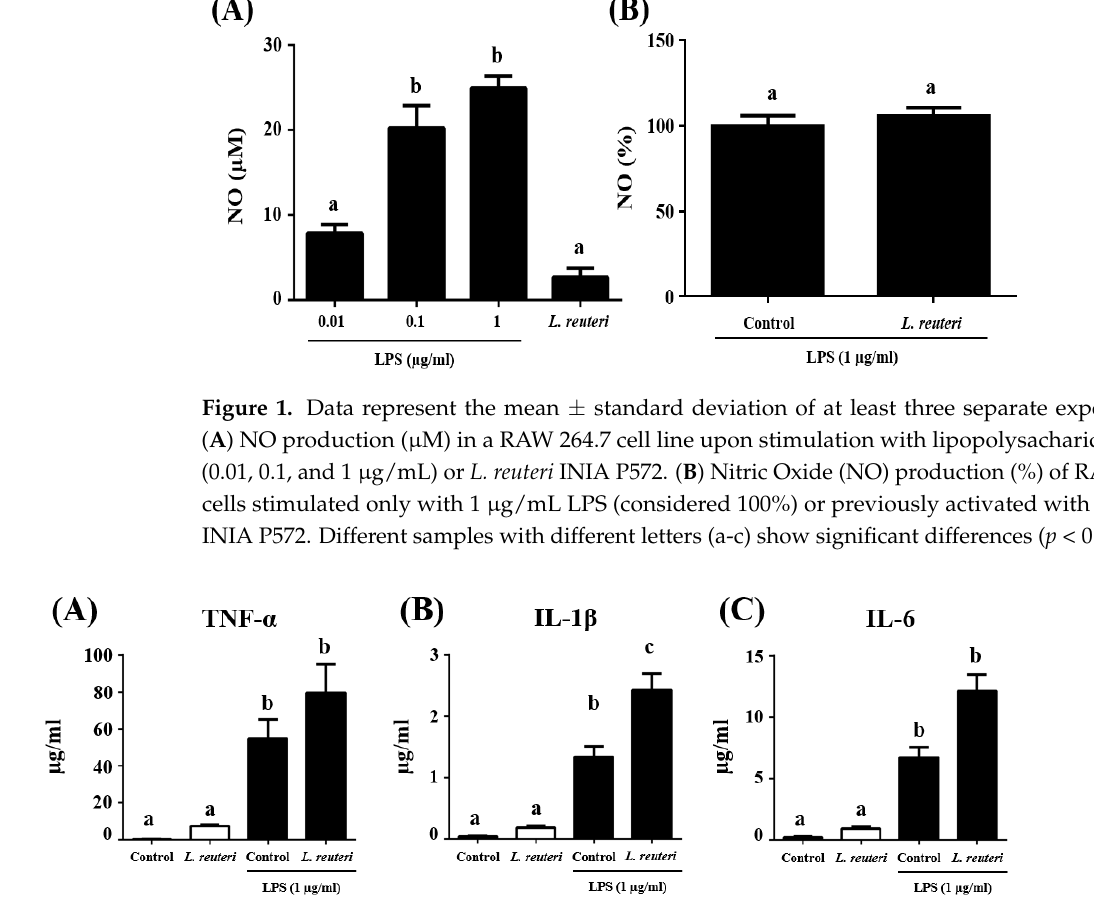
Figure 2. Tumor necrosis factor- α (TNF - α) ( A ), interleukin- 1β (IL - 1β) ( B ), and interleukin-6 (IL-6 ) ( C ) levels (µg/mL) in RAW 264.7 cells, untreated (white) or treated with 1 µg/mL lipopolysaccharides (LPS) (black), and/or pre-stimulated with L. reuteri INIA P572. Data represent the mean ± standard error of the mean. Different samples with different letters (a–b) show significant differences ( p < 0.05).